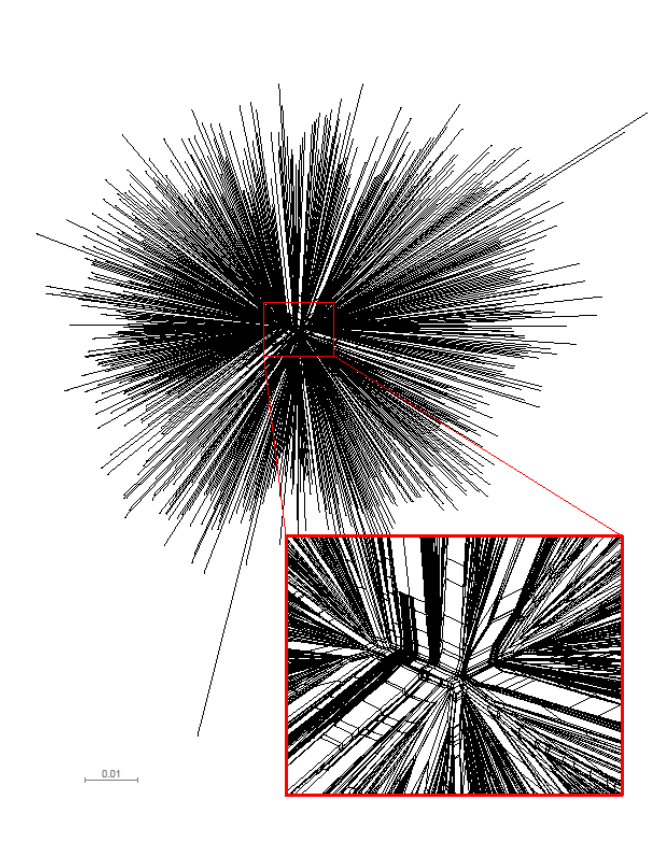
Figure 2. Phylogenetic network of HIV-1 subtype C gag sequences (n=653). The presented split network was generated by SplitsTree v4 [32,33] using the NeighborNet approach. To highlight multiple splits and parallel branching, the central part of the split network is